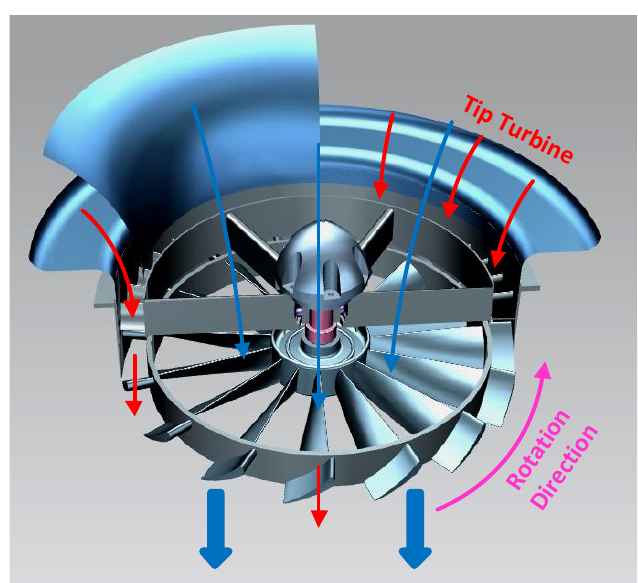
Figure 1. High-bypass propulsion system, including the air-driven fan with a tip turbine.